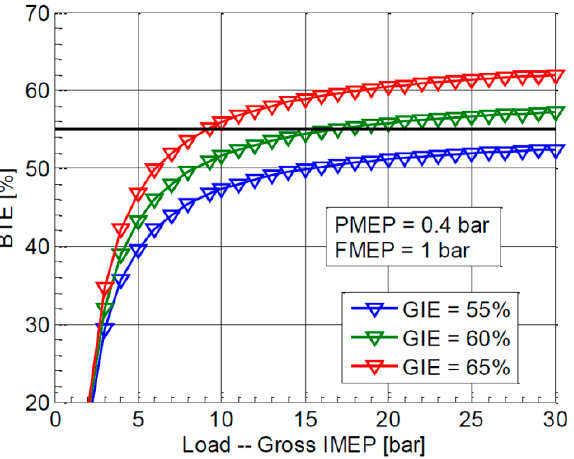
Figure 11. BTE as a function of IMEPg and gross thermal efficiency(GTE) (GIE: gross indicated efficiency synonymous to GTE) [16].